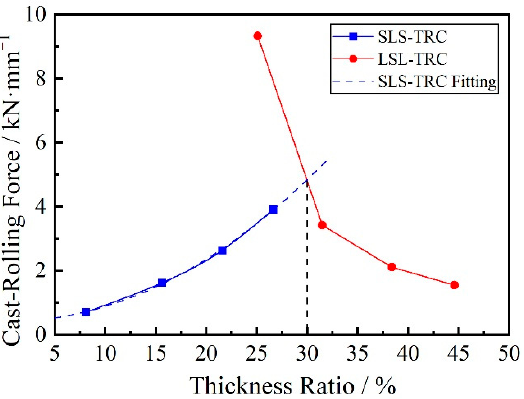
Figure 19. Variation law of cast-rolling force with outlet thickness fraction in two processes.